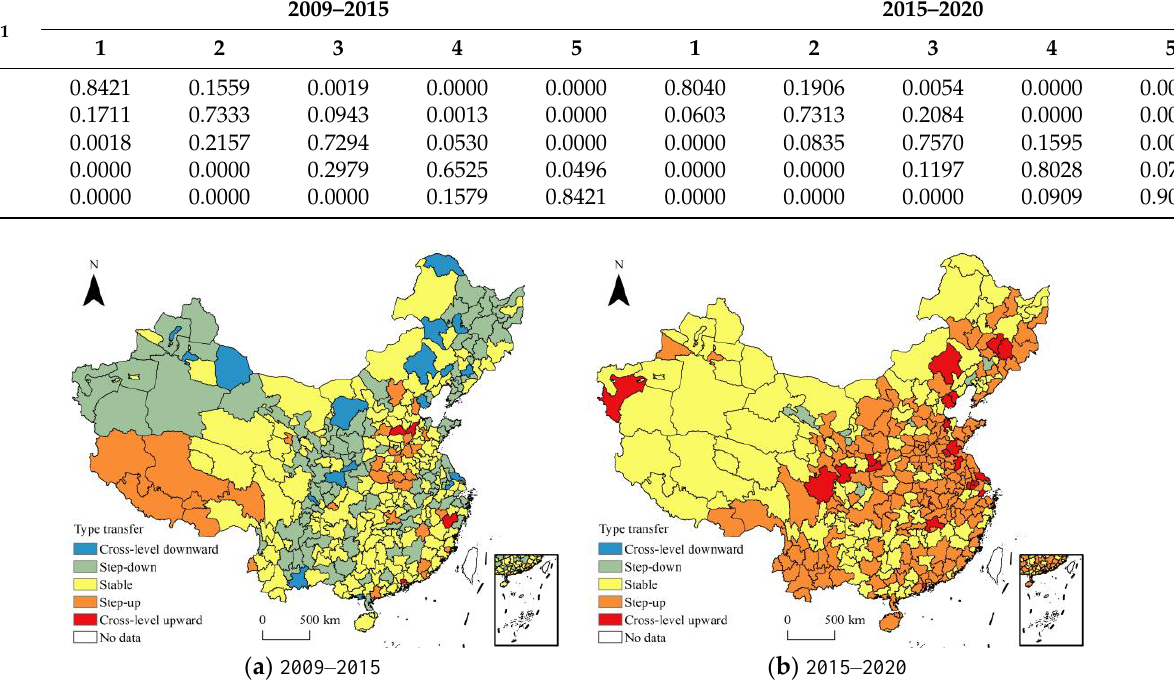
Figure 2. Spatial differentiation pattern of type transfer of PIR in China.